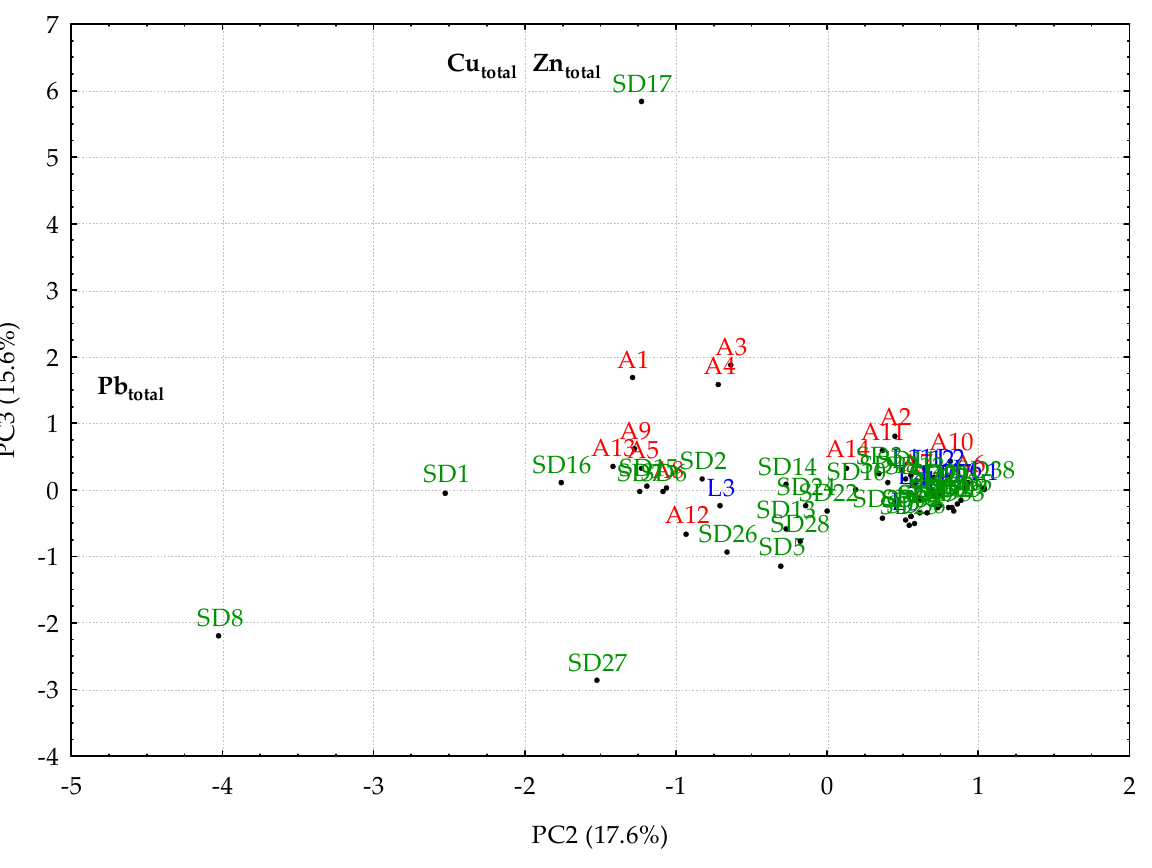
Figure 8. Scores of each sample on the principal components, PC2 versus PC3. The most important parameters for the definition of the two components are shown on the edge of each axis, indicating the direction in which the value of the parameter increases (Cu total , Pb total , and Zn total : pseudo-total element concentrations aqua-regia digestion). The color of the label indicates the mine: red for Aljustrel; blue for Lousal; and green for São Domingos.